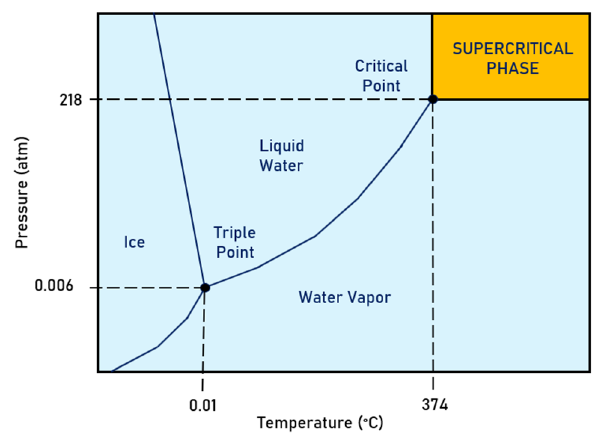
Figure 6. Water phase diagram highlighting the supercritical water region.